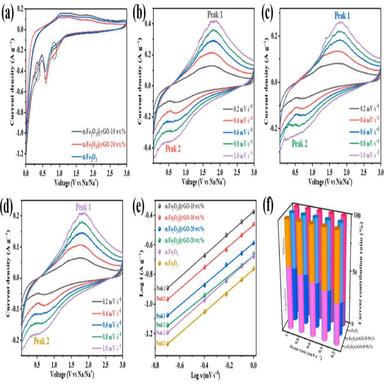
(a) CV spectra of α-Fe2O3 and α-Fe2O3@rGO core@shell nanocubes in a first cycle at a scan rate of 0.2 mV s − 1 , (b–d) CV spectra of α-Fe2O3@rGO-10 wt%, α-Fe2O3@rGO-20 wt%, and α-Fe2O3 at scan rates between 0.2 and 1.0 mV s − 1 , respectively, (e) Log i vs. Log ν plot, and (f) 3D plot of capacitive and diffusion current contribution ratio of α-Fe2O3 and α-Fe2O3@rGO core@shell nanocubes.